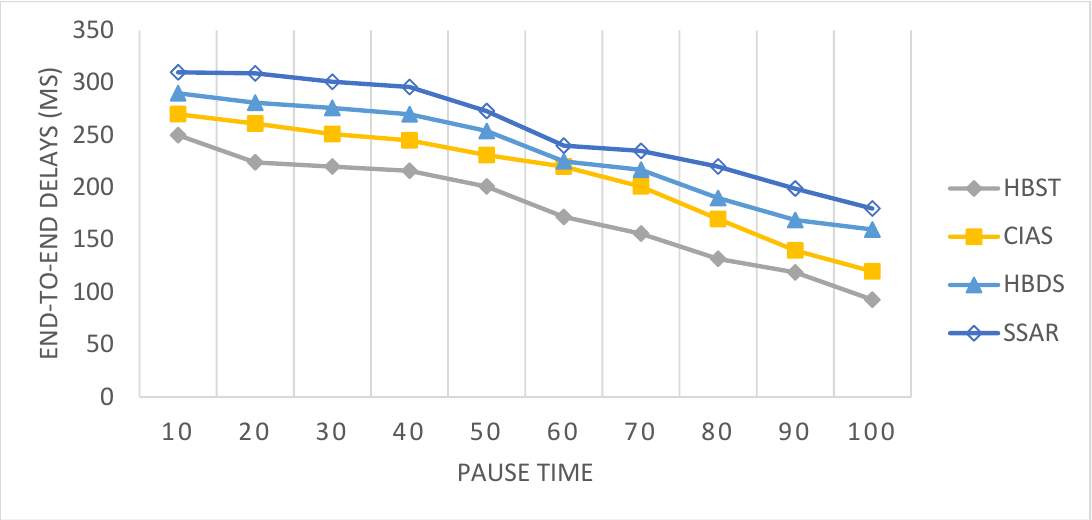
Figure 9. End-to-end delays for the network with 50% selfish nodes.